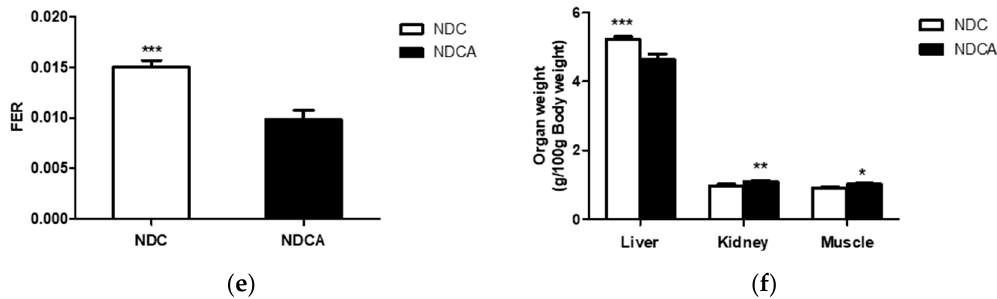
Figure 1. Effects of supplementation of non-dairy creamer-enriched high-fat diet with D-allulose on body weight, food efficiency ratio (FER; body weight gain/energy intake per day), and organ weights in C57BL/6J mice fed a high-fat diet for 8 weeks: ( a ) food intake; ( b ) energy intake; ( c ) body weight; ( d ) total body weight gain; ( e ) FER; ( f ) organ weight. Data are mean ± SE. Significant differences between the 5% D-allulose group and without D-allulose group are indicated; * p < 0.05, ** p < 0.01, *** p < 0.001. NDCA, high-fat diet with non-dairy creamer + 5% D-allulose; NDC, high-fat diet with non-dairy creamer.